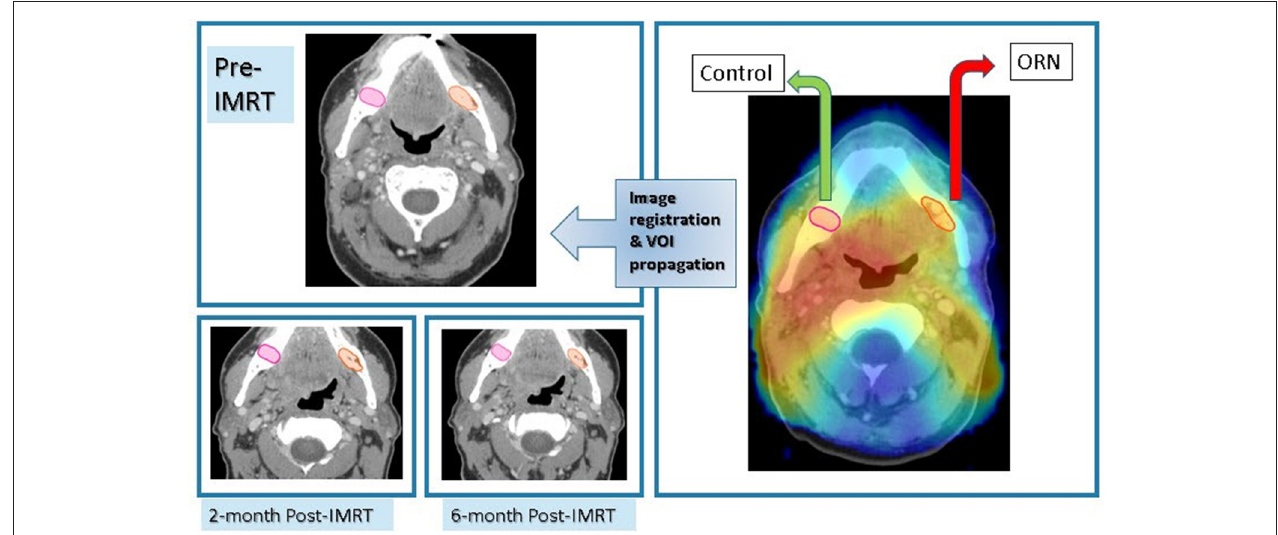
FIGURE 2 | Imaging workflow. Registration of CECT scan at time of diagnosis of ORN to radiation dose grid as well as previous CECT scans at: baseline, 2-month, and 6-month post-RT for each patient with subsequent propagation of ORN & “Control”